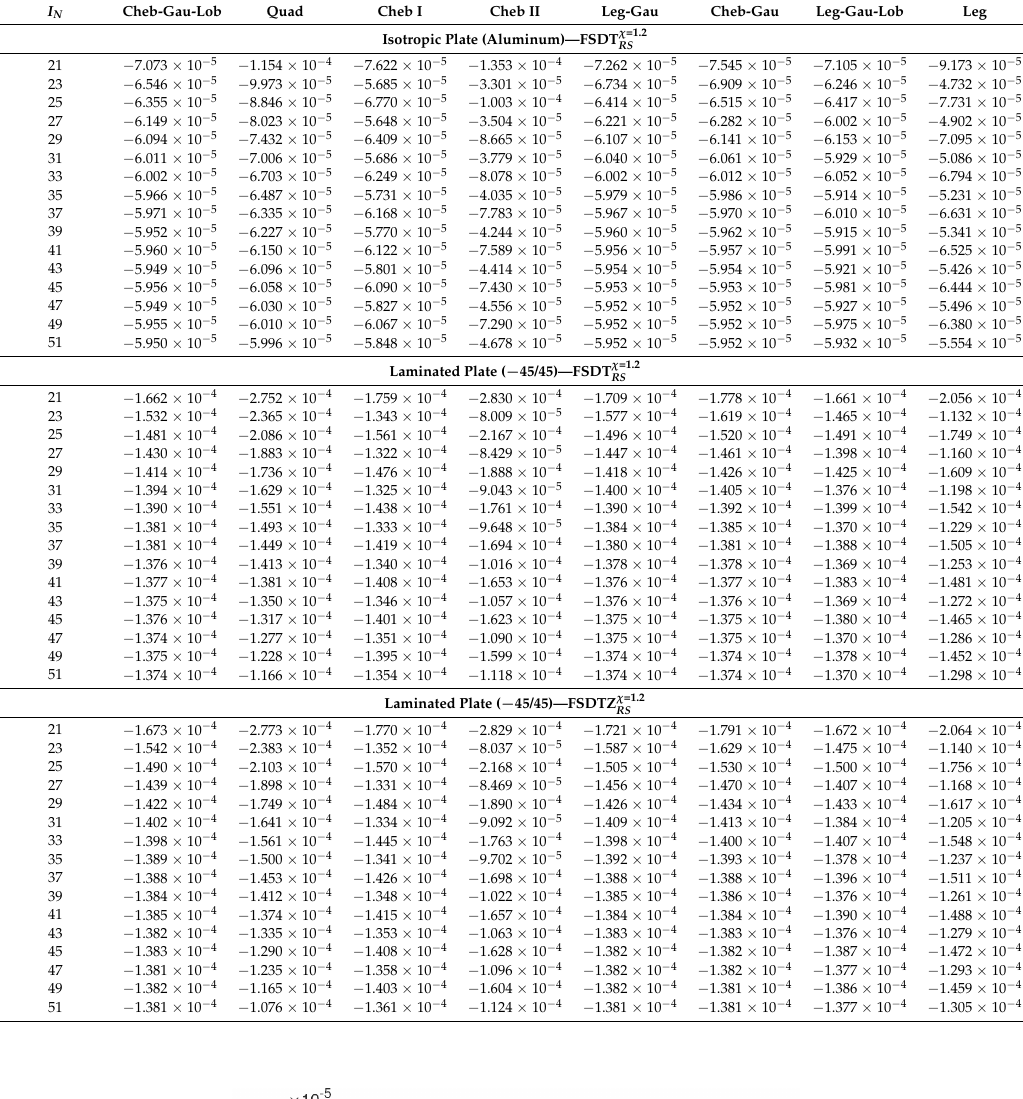
Table 6. Convergence analysis in terms of central deflection [m] for the SSSS square plate increasing the number of grid points I N = I M for several grid distributions, lamination schemes and Higher-order Shear Deformation Theories (HSDTs).